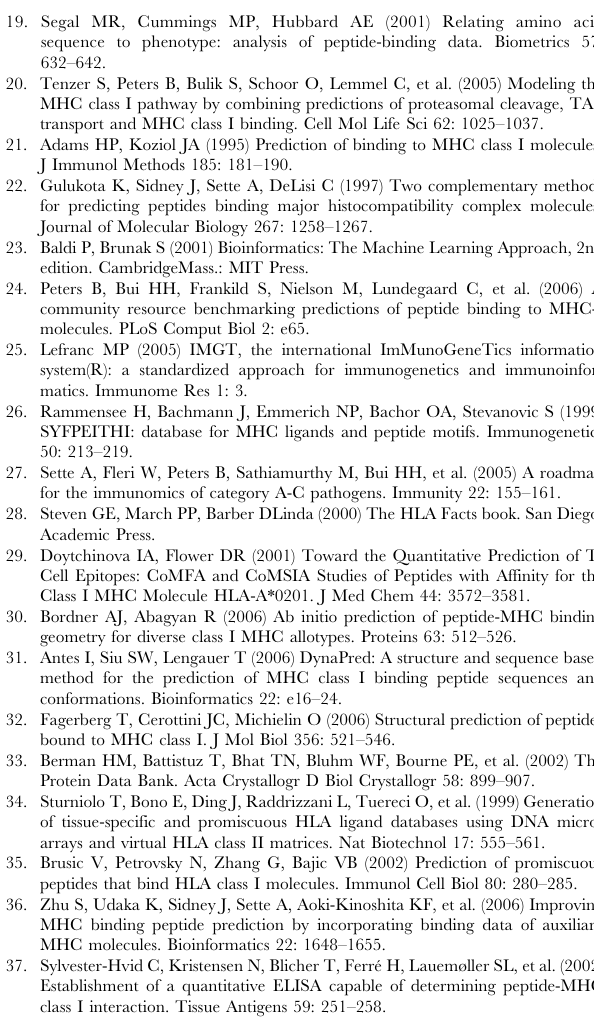
for the non-supertype representing alleles. The final column gives the number of peptide data for each allele. Table S2 Nearest neighbor identification for the 24 HLA-A and 18 HLA-B alleles. HLA-A and HLA-B allele nearest neighbor identification. (A) gives the nearest neighbor identification for the HLA-A alleles, (B) gives the nearest neighbor identification for the HLA-B alleles. The first column gives the allele name, the second column gives the Pan (leave-one-out pan-specific neural network) performance in terms of the Pearson correlation coefficient. The third and fourth columns give the allele name of the nearest neighbor and distance as determined from alignment of the pseudo sequences, the fifth column gives the predictive perfor- mance of the Neighbor method in terms of the Pearson correlation coefficient. Finally, the last column gives the number of data point available for the neighbor allele.